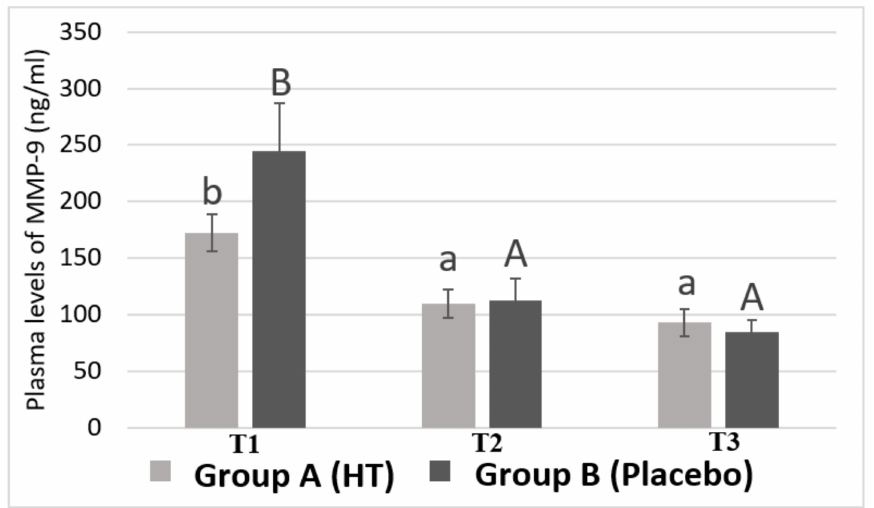
Figure2. PlasmalevelsofMMP-9inwomenwithbreastcancer. Valuesareshownasthemean ± standard error of the mean. Bars not sharing superscript letters are statistically di ff erent at p < 0.05 for each experimental group (lowercase for Group A treated with hydroxytyrosol and uppercase for Group B treated with placebo) at each time point (TI, T2 and